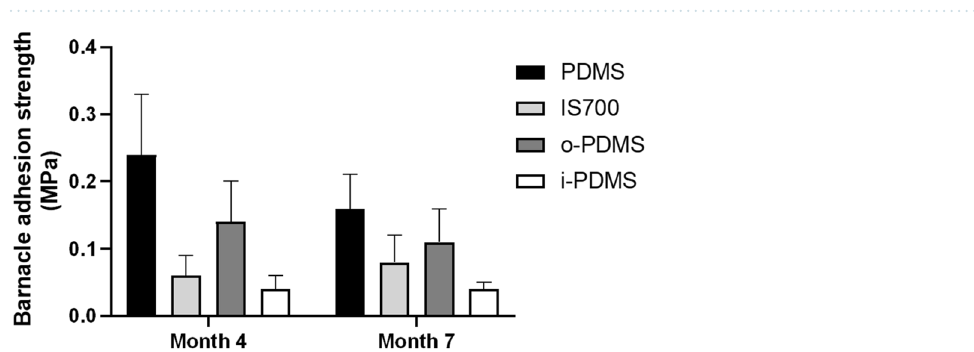
Figure 6. Barnacle adhesion strength to PDMS, IS700, o-PDMS and i-PDMS at Port Canaveral after 4- and 7-months static immersion, number of samples (N) = 6. Error bars = standard deviation